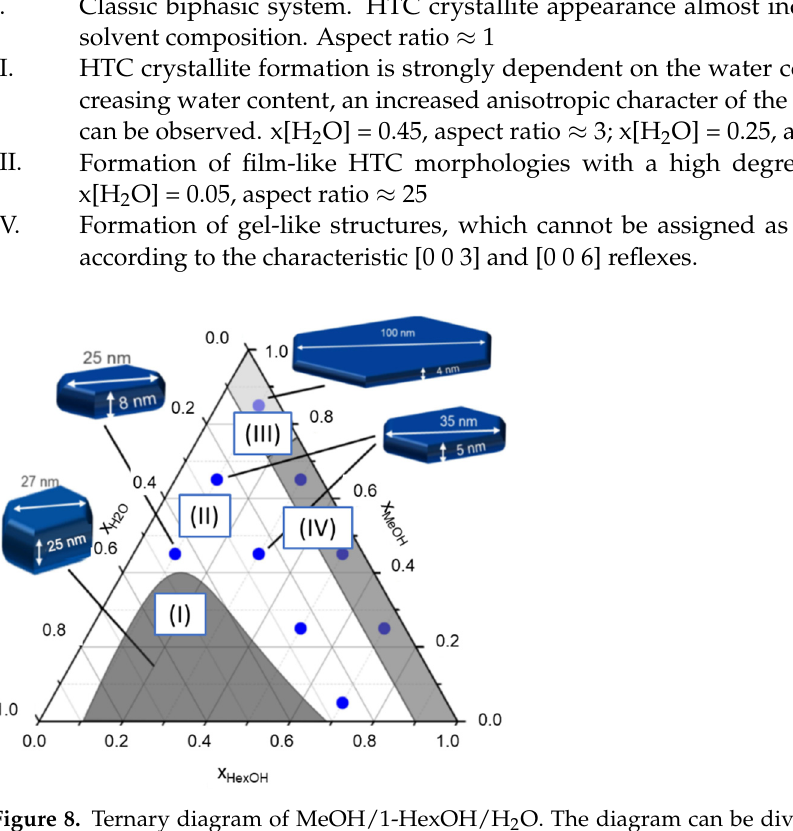
Figure 8. Ternary diagram of MeOH/1-HexOH/H 2 O. The diagram can be divided into four hydrolysis areas using HTC synthesis strategy B. Crystallite size along the c-axis determined by X-ray diffraction programs. Crystallite size along the a- or b-axis determined by evaluating the microscopy images of the samples.